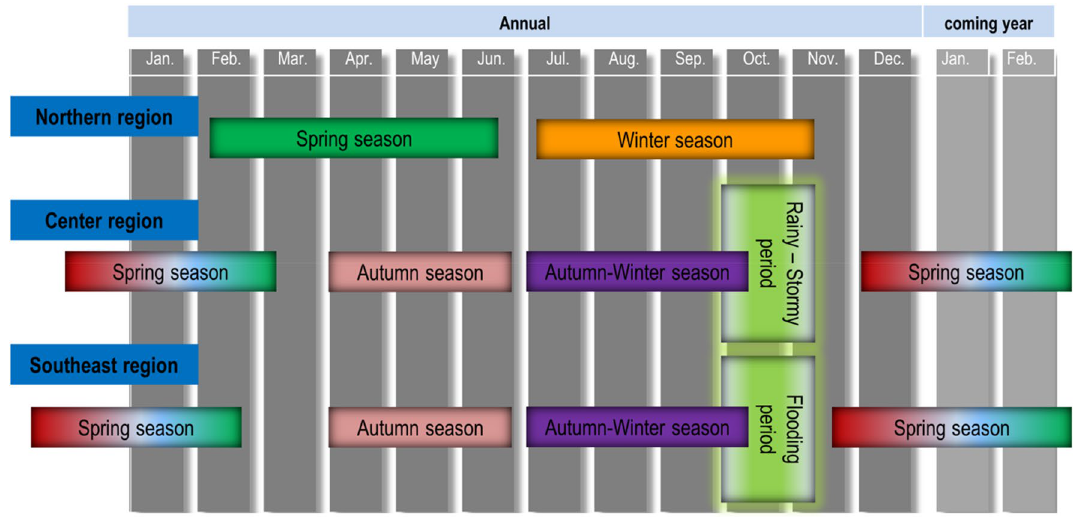
Figure 3. Rice cultivation seasons in three geological regions of